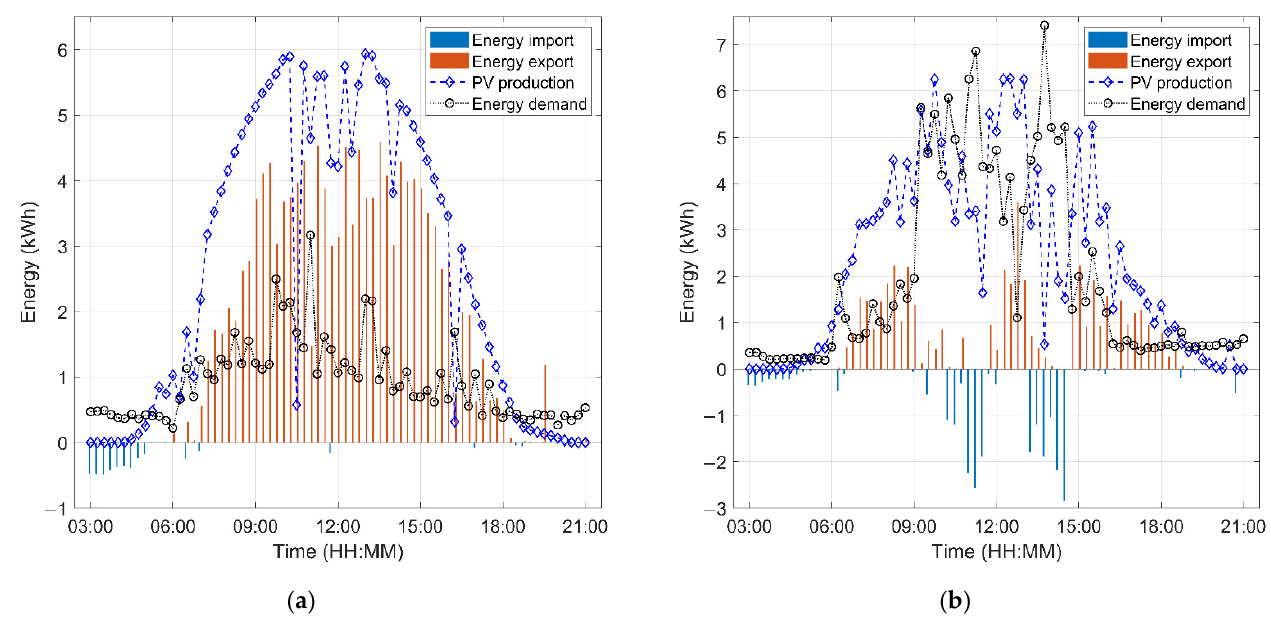
Figure 9. PV energy production, load, energy import, and export during ( a ) sunny day of July 2020 and ( b ) partly cloudy day of July 2020.